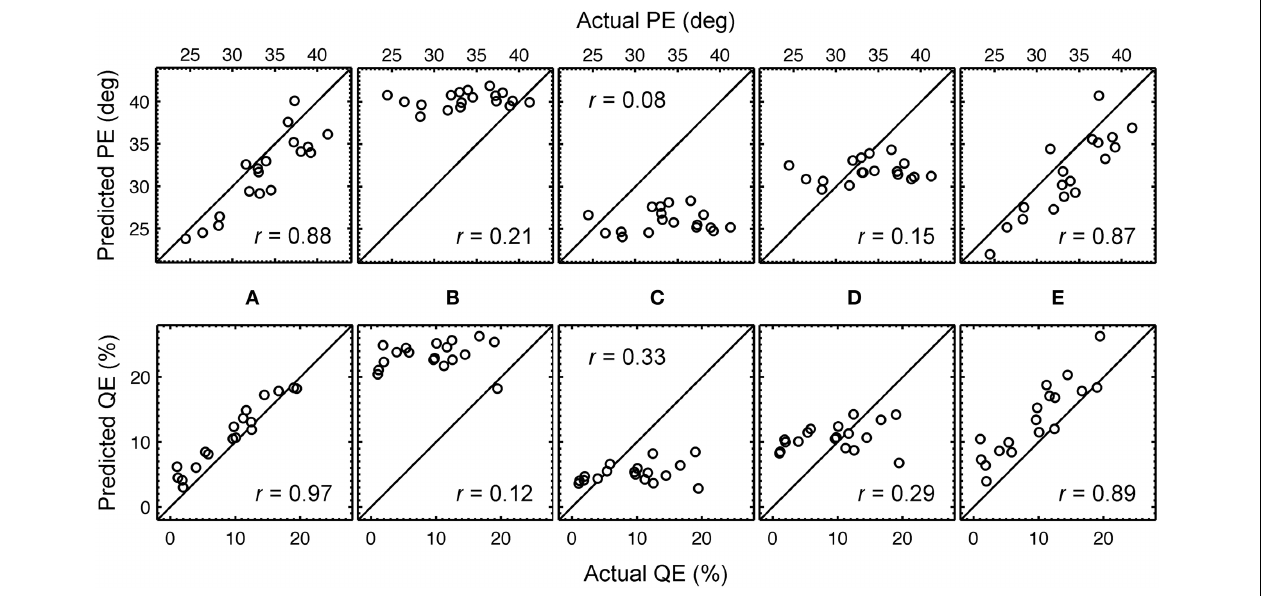
best correlation for QE, U = 1 . 87. (D) Listener-constant uncertainty from (Langendijk and Bronkhorst, 2002), U = 2 . 0. (E) Listener-specific uncertainties U k and the same DTF set ( k = 14) for all listeners (see Section 3.3 for more details). The correlation coefficient is denoted by r